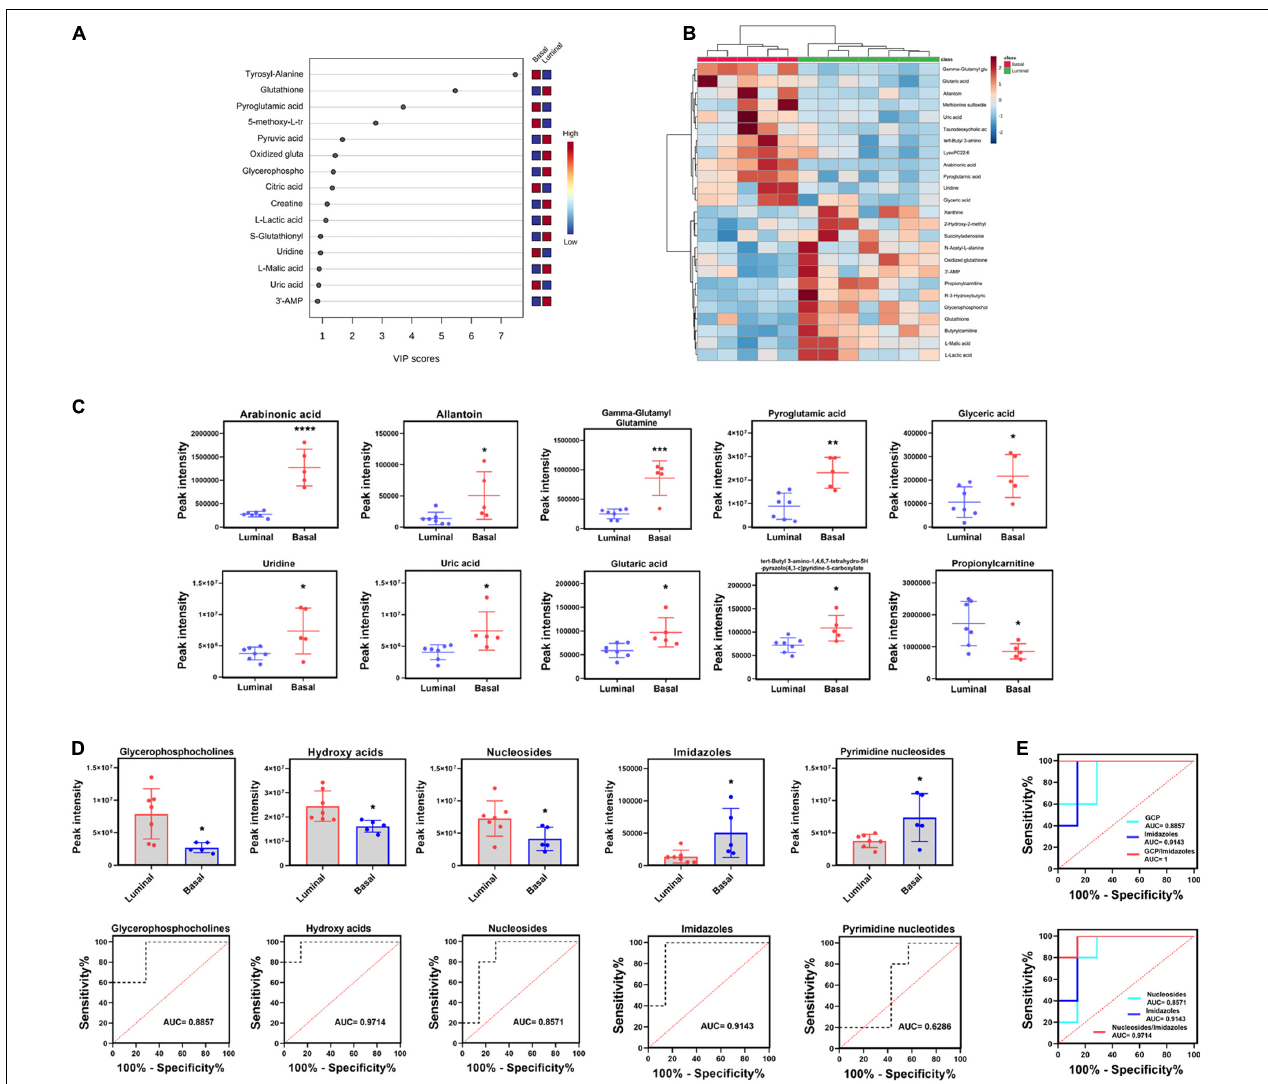
FIGURE 6 | Potential metabolite biomarkers of basal and luminal MIBC subtypes. (A) VIP score of altered metabolites. (B) Heatmap of the top 25 altered metabolites in basal and luminal MIBC subtypes. (C) The peak intensity of the top 10 significantly differential metabolites in basal and luminal MIBC subtypes. (D) The peak intensity and AUC values of GCP, hydroxy acids, nucleosides, imidazoles, and pyrimidine nucleosides. (E) The AUC values of GCP/imidazoles and nucleosides/imidazoles ratios. * indicates p < 0.05; ** indicates p < 0.01; *** indicates p < 0.001; **** indicates p <